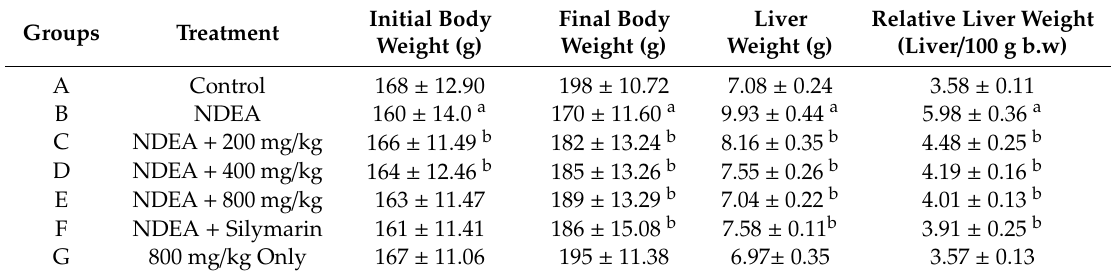
Table 1. E ff ect of Cajanus cajan on the body and liver weight.